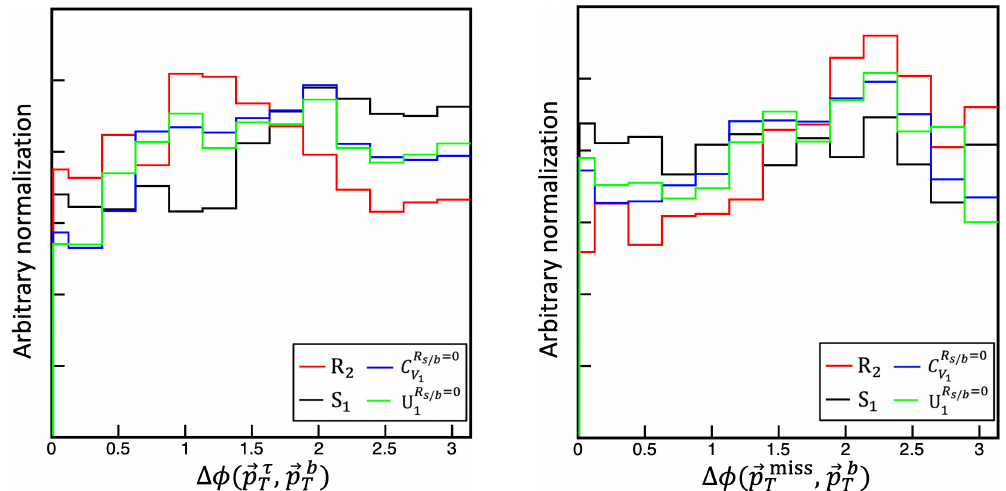
Figure 9 . Distribution of signal event numbers against ∆ φ ( ~p τ in each LQ scenario. The color convention is the same as in figure 8. Here, M LQ = 1 . 5 TeV is taken, and the normalization of each histogram is